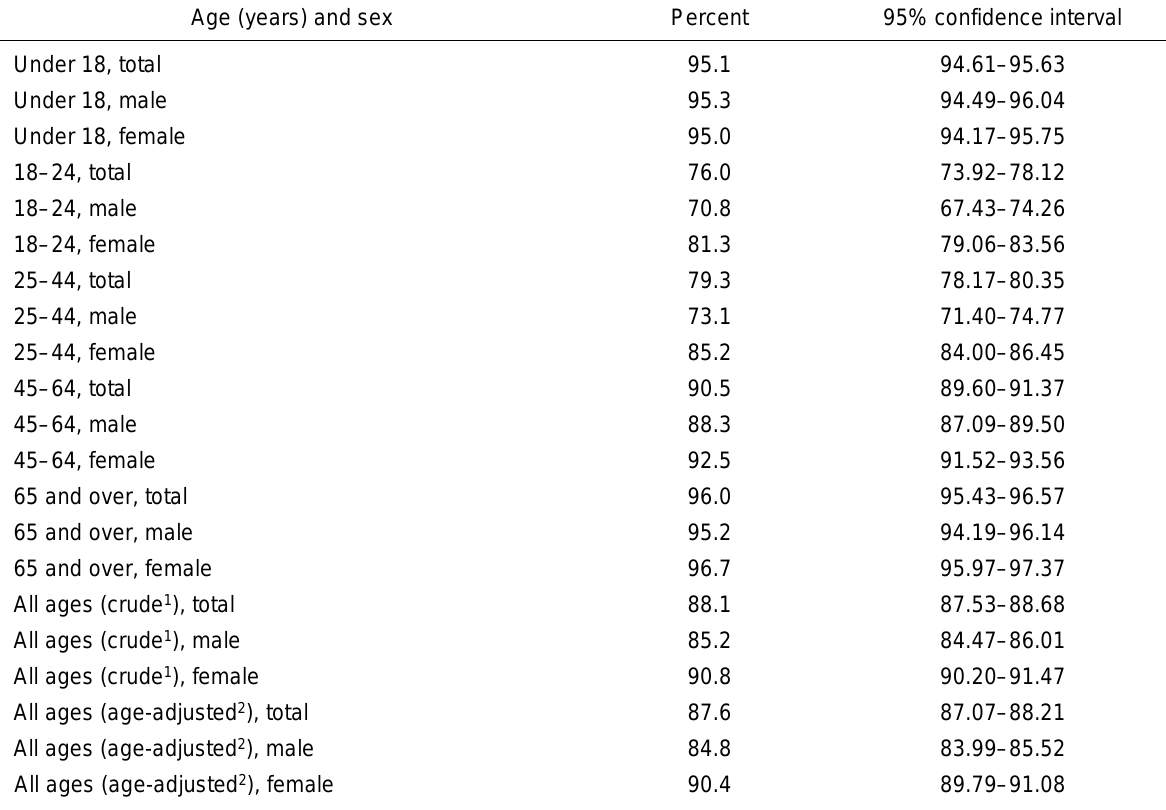
Data table for Figure 2.2. Percentage of persons of all ages with a usual place to go for medical care, by age group and sex: United States, 2016